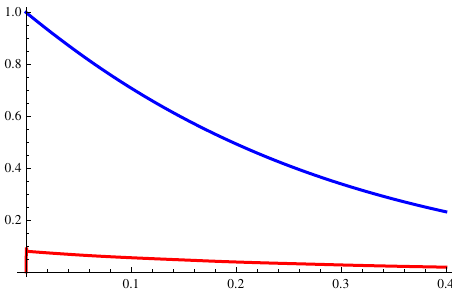
Figure 7. The synchronization dispersion D ( t ) for the diffusion - Kuramoto problem (3.6) with initial data (3.7). The red line represents D ( t ) multiplied by the factor 10 11 , when k = 0 ,(cid:96) = 0, while the blue one represents D ( t ) in the case k = 5 ,(cid:96) = 6